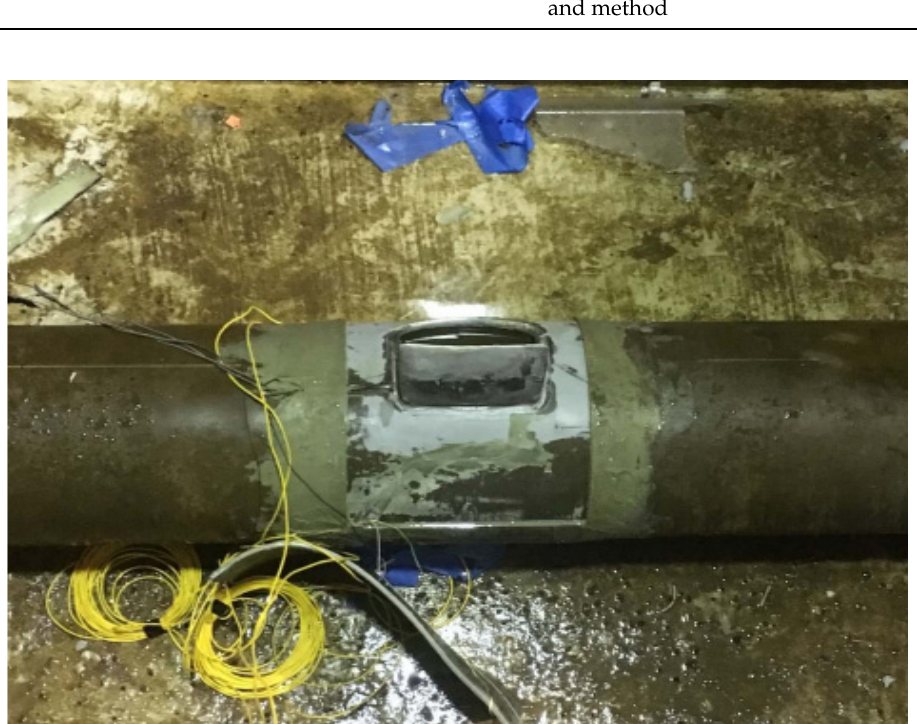
Figure 25. Typical composite pipe that is repaired with ComposiSleeveTM sample after pressure testing showing the attached optical fiber sensors (Reprinted/adapted with permission of Dr Chris Alexander. Copyright 2018 ASME & Chris Alexander. Source: Ref. [377]).